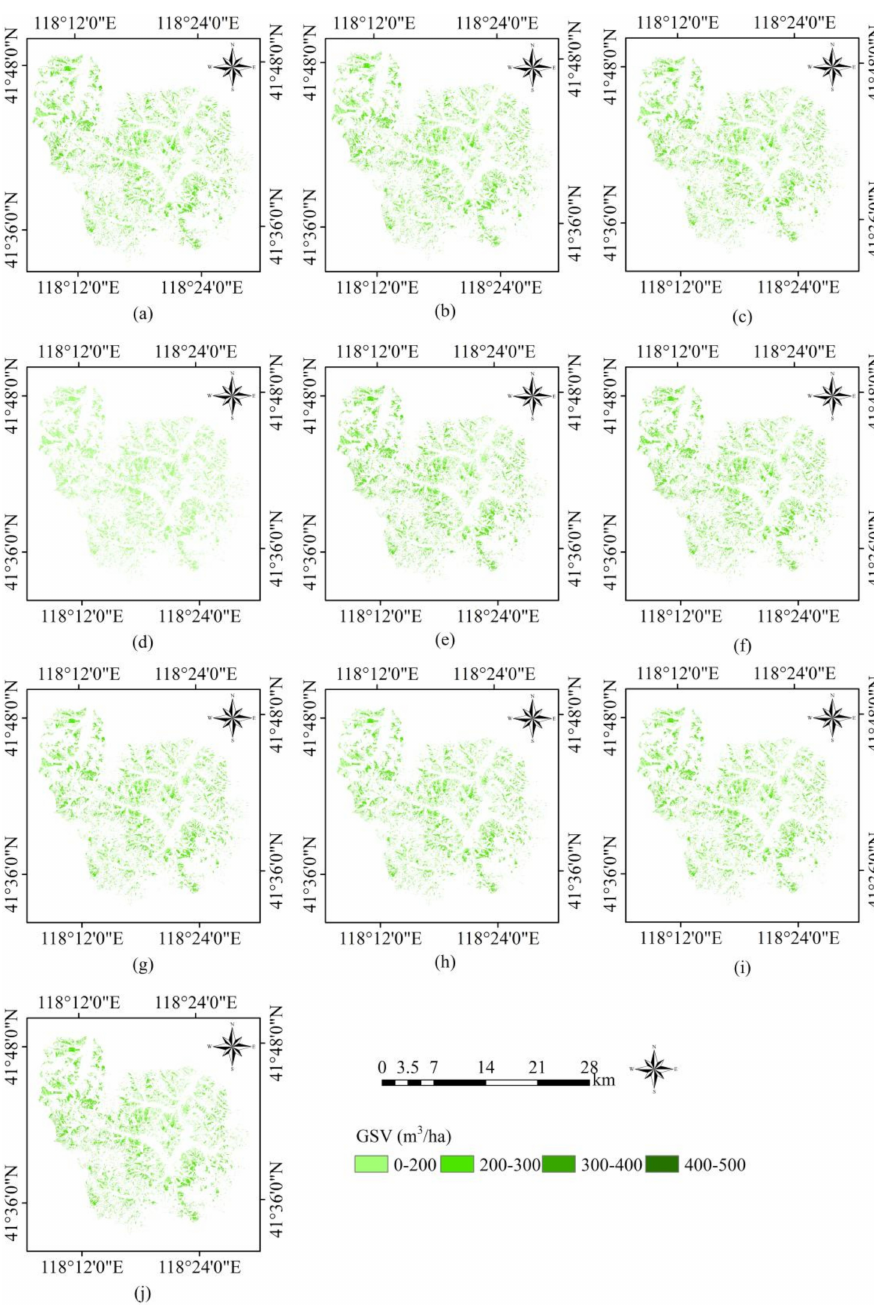
Figure11. SpatialdistributionsofGSVestimatesintheWangyedianforestfarmpredictedby( a )LSR-RFR without texture features, ( b ) RF-RFR without texture features, ( c ) Boruta-RFR without texture features, ( d ) VSURF-RFR without texture features, ( e ) SRF-RFR without texture features, ( f ) LSR-RFR with texture features, ( g ) RF-RFR with texture features, ( h ) Boruta-RFR with texture features, ( i ) VSURF-RFR with texture features, and ( j ) SRF-RFR with texture